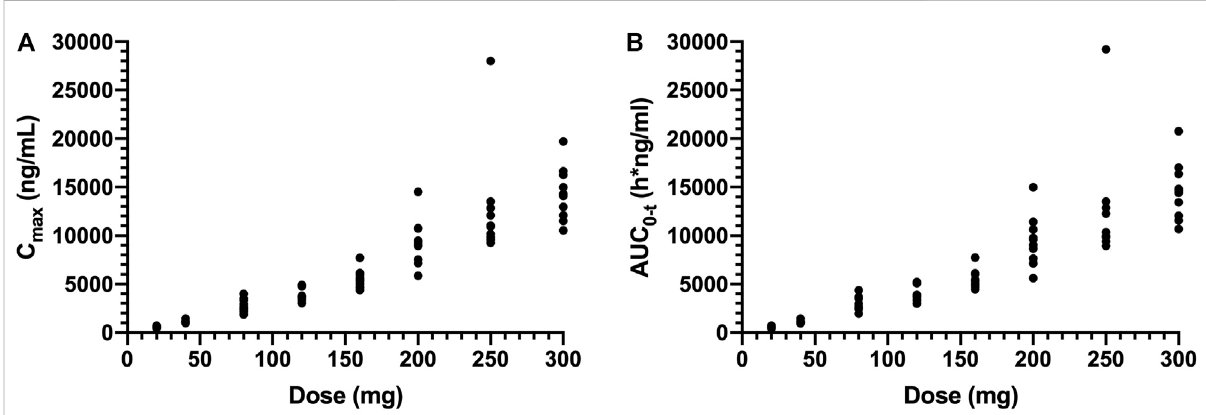
FIGURE 2 Plot of individual of C max (A) and AUC 0-t (B) values versus dose in single ascending-dose study (20, 40, 80, 120, 160, 200, 250, and 300 mg). C max , the maximum plasma concentration; AUC 0-t , the area under the plasma concentration – time curve from 0 to the last measurement time.